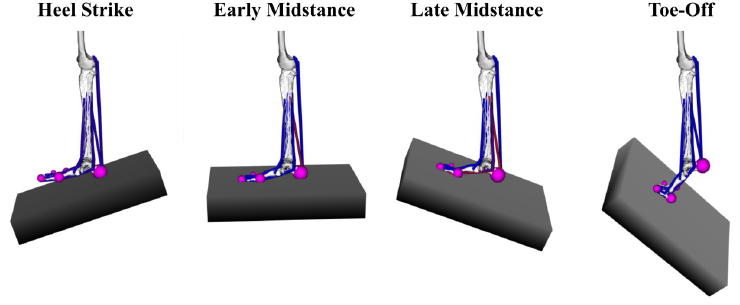
Fig 8. Simulation of stance phase of gait. Gait simulation kinematics of the stance phase of gait through a healthy foot model. The tibia of the model is held fixed while a moving ground plane tracks the inverse motion of gait at heel strike, early midstance, late midstance, and toe